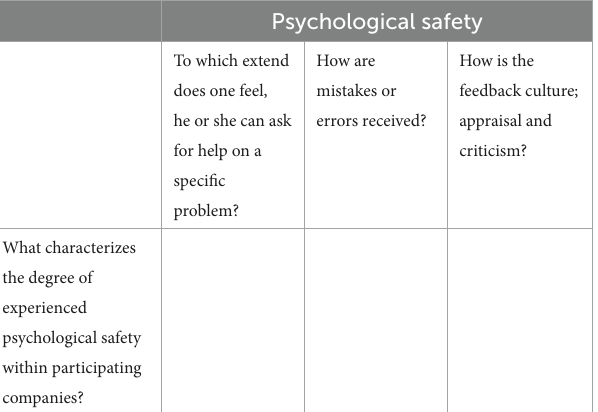
TABLE 3 Categorization matrix, psychological safety.